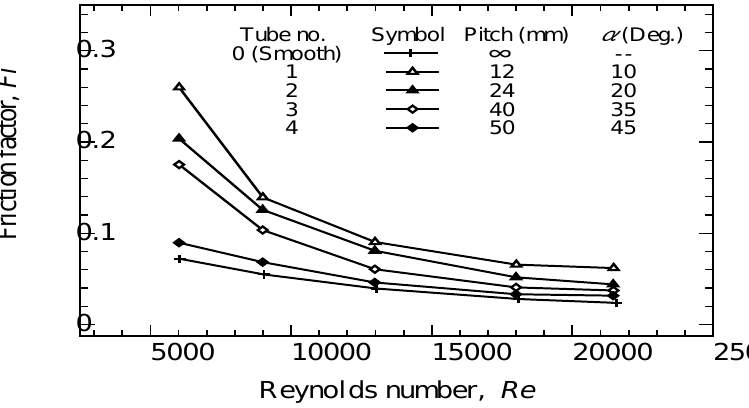
Figure 3: Variation of average friction factor against Reynolds number for smooth tube and wire-coil inserted tubes.